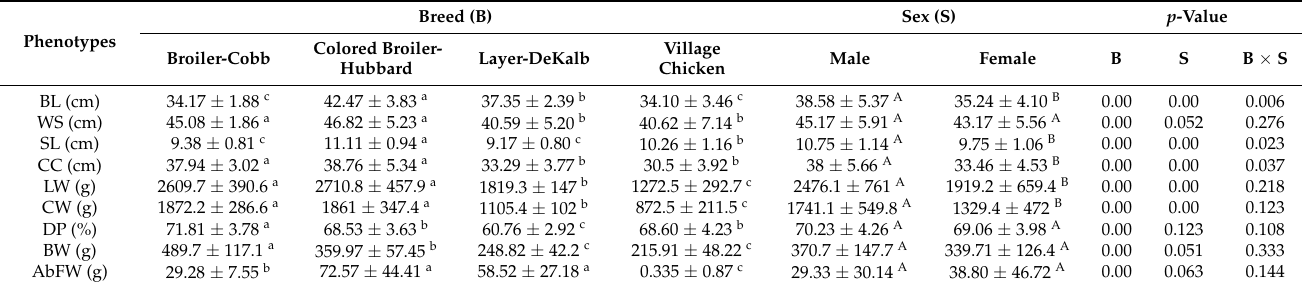
Table 2. Effect of breed and sex on the live weight, body size, and carcass characteristics of four chicken breeds in Malaysia.